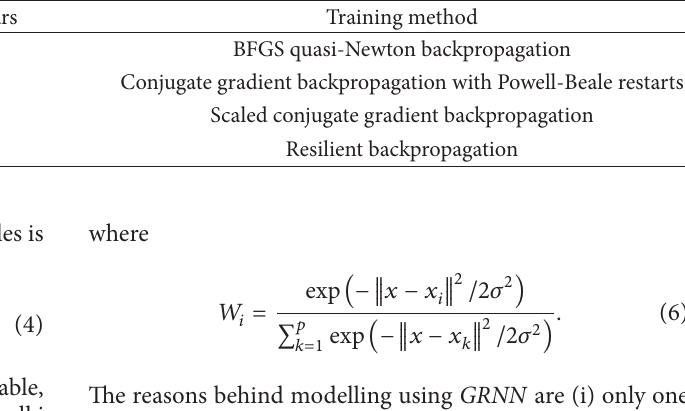
Table 3: Model parameter setting for MLP